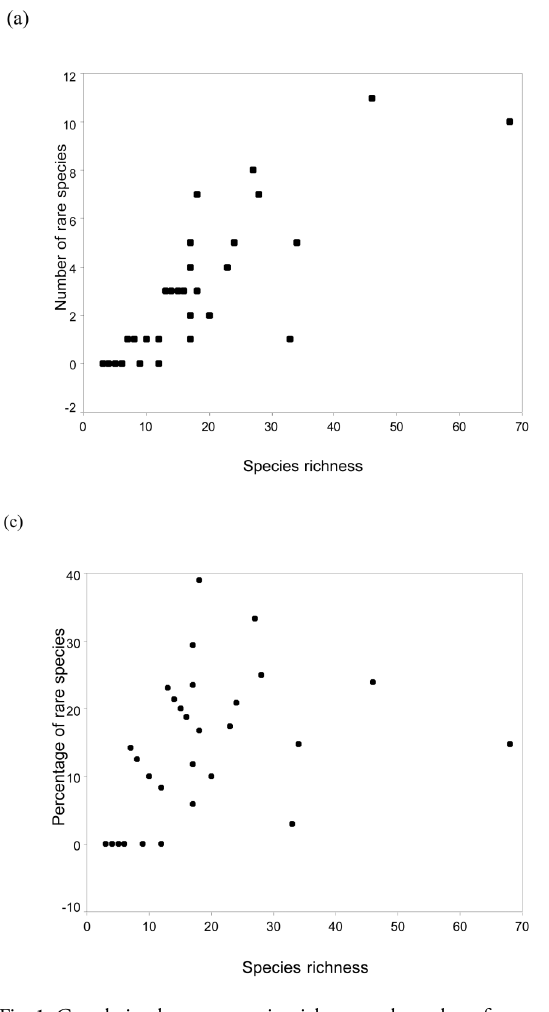
Fig. 1. Correlation between species richness and number of rare species (graphic a), number of very rare species (graphic b), percentage of rare species (graphic c), and percentage of very rare species (graphic d), in snake communities throughout the